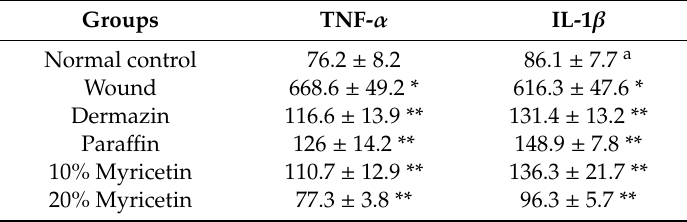
Table 2. E ff ect of myricetin treatment on serum levels of TNF- α and IL-1 β in rats with the wounded